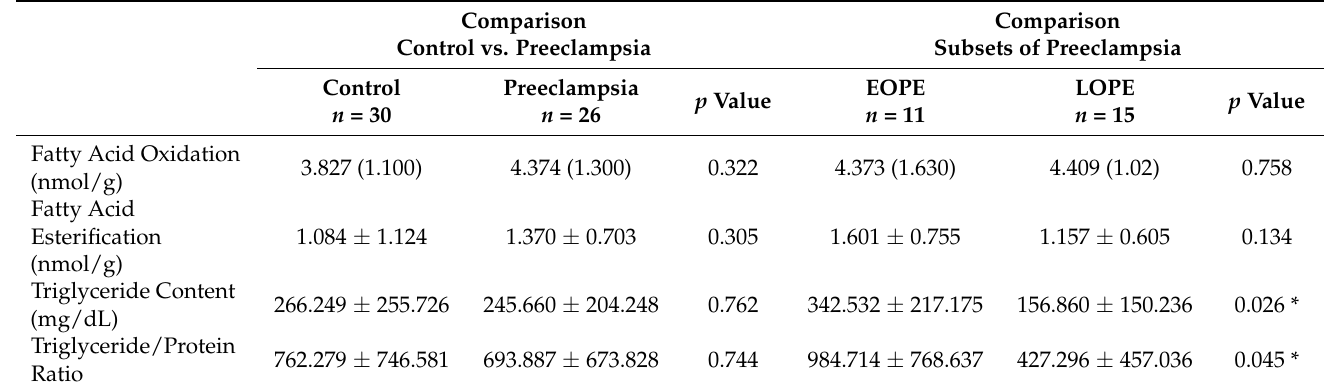
Table 3. Analysis of lipid metabolism in placental